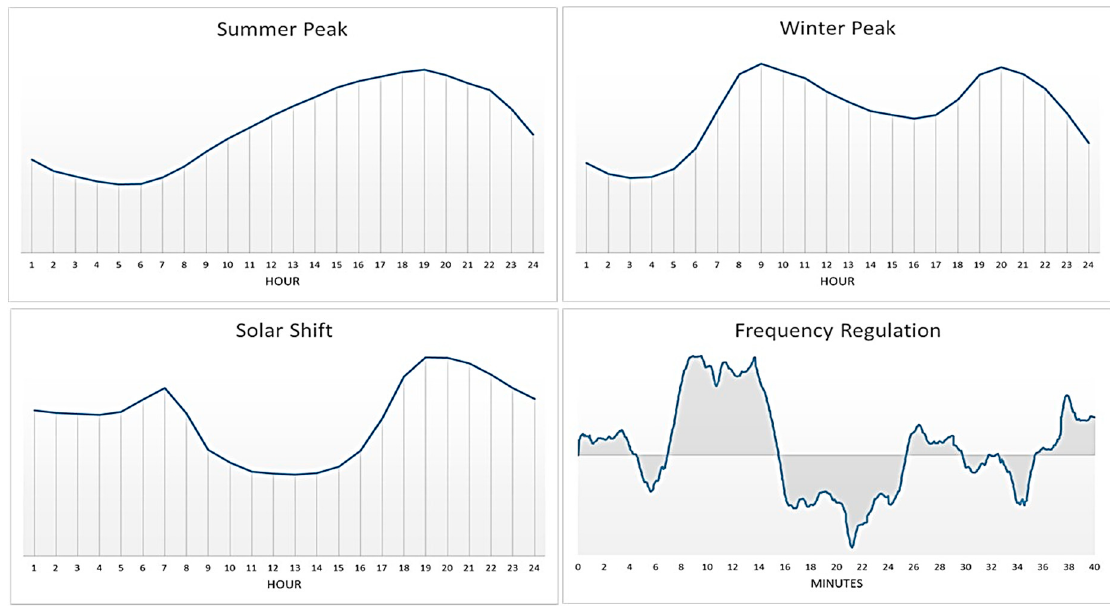
Figure 2. Illustrative system prototypes representing Summer peak shed (ISO-NE weekday average load in August 2018), Winter peak shed (Northwest weekday average load in February 2018), Solar shift (CAISO net load on 5 March 2018), and Frequency regulation (PJM RegD normalized signal). The Summer and Winter Peak prototypes illustrate the normalized hourly demand curve of the system; the Solar Shift system prototypes illustrate normalized hourly net load on the system; and the Frequency Regulation illustrates normalized fast frequency response needed both in the positive and negative direction over a period of 40 min [29–31].